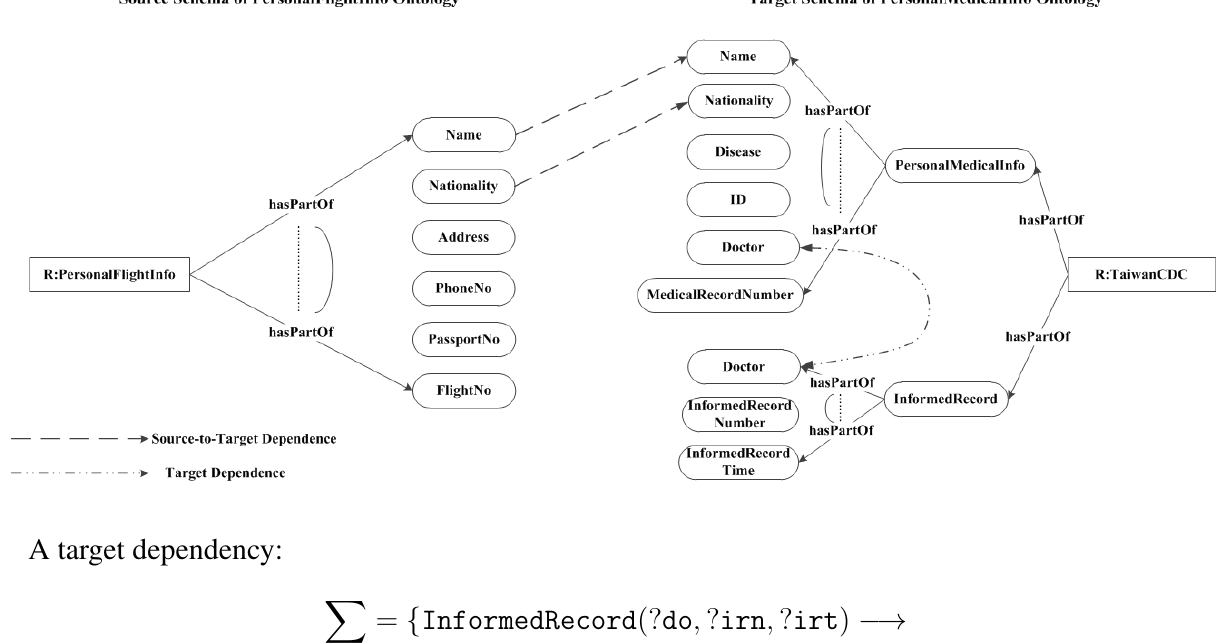
Figure 3. A source-to-target dependency flight information to the target schema of medical